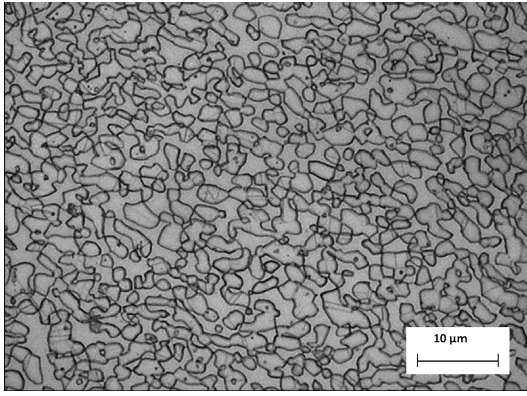
Figure 1. Cross section micrograph of the UNS S32205 sample after etching.